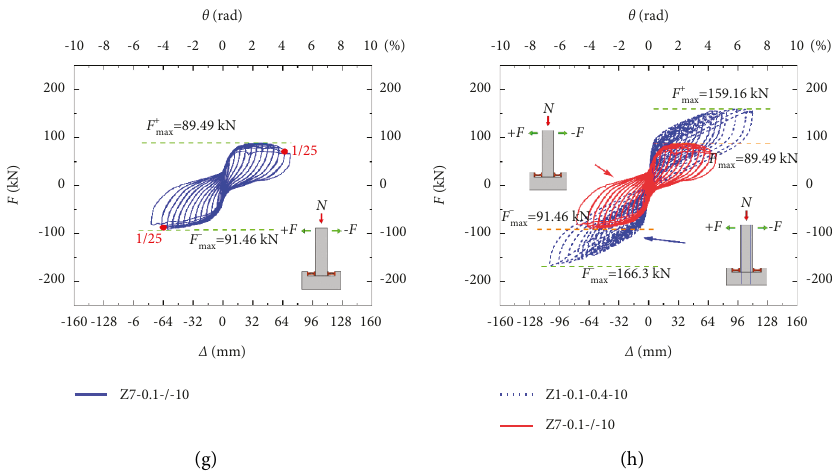
Figure 13: Hysteretic curves of different working cases. (a) Specimen 1. (b) Specimen 2. (c) Specimen 3. (d) Specimen 4. (e) Specimen 5. (f) Specimen 6. (g) Specimen 7. (h) Comparison of force-displacement hysteresis curves of Specimen 1 and Specimen